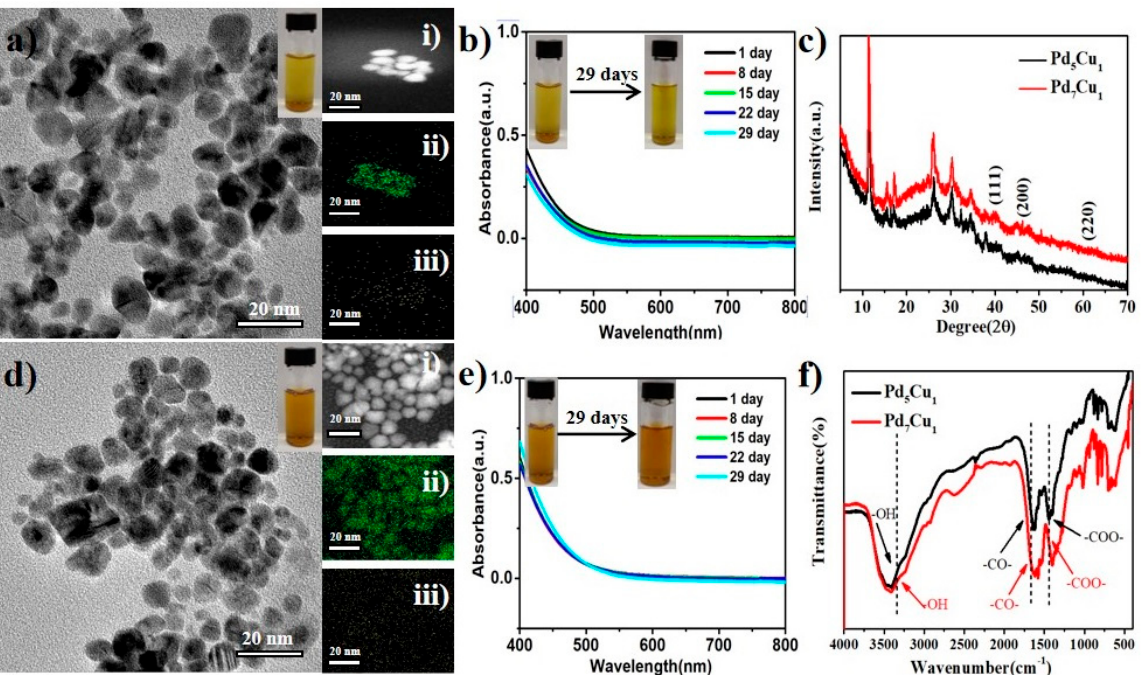
Figure 1. ( a , d ) TEM images of the Pd5Cu1 and Pd7Cu1 alloy NPs, respectively. The inset images are colloidal solution. ( i )-HAADF-STEM images of Pd5Cu1 and Pd7Cu1 alloy NPs, the EDX mapping of Pd and Cu elements of Pd-Cu alloy NPs are illustrated in ( ii ) and ( iii ); ( b , e ) UV-vis absorption spectra of the Pd5Cu1 and Pd7Cu1 alloy NPs in the 29 days; ( c ) XRD of the Pd5Cu1 and Pd7Cu1 alloy NPs; ( f ) FT-IR spectra of Pd5Cu1 and Pd7Cu1 alloy NPs.